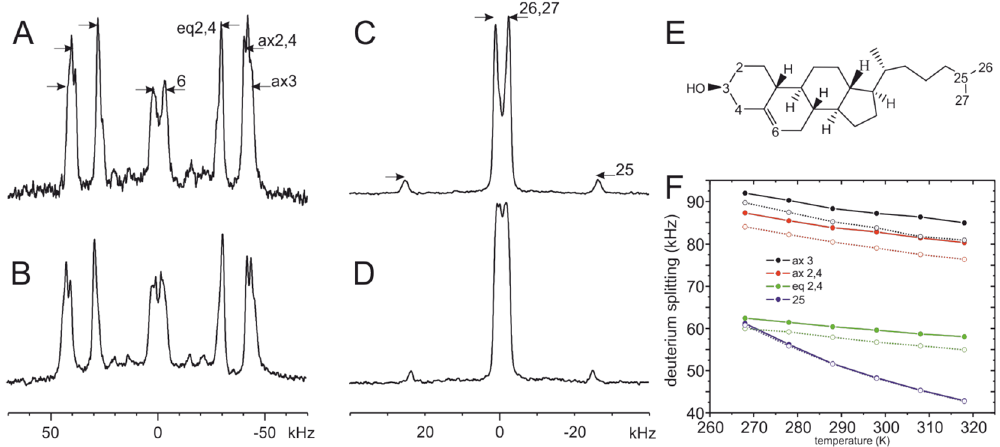
Figure 6. Deuterium solid-state NMR spectra of [2,2,3,4,4,6]- 2 H 6 -cholesterol ( A , B ) or [25, 26 3 , 27 3 ]- 2 H 7 - cholesterol ( C , D ) in the absence ( A , C ) or presence ( B , D ) of 2 mol% CRAC-TM_gp41 in POPC/cholesterol 90/10 mol/mole membranes. ( E ) Structure of cholesterol where the deuterated sites are numbered. ( F ) The deuterium quadrupolar splittings extracted from the corresponding 2 H solid-state NMR spectra as a function of temperature in the absence (solid lines, closed symbols) or presence of 1 mol% CRAC-TM_model (hatched line, open symbols). Positions 2 and 4 carry two deuterons each with different alignments (axial and equatorial relative to the ring system) and therefore different quadrupolar